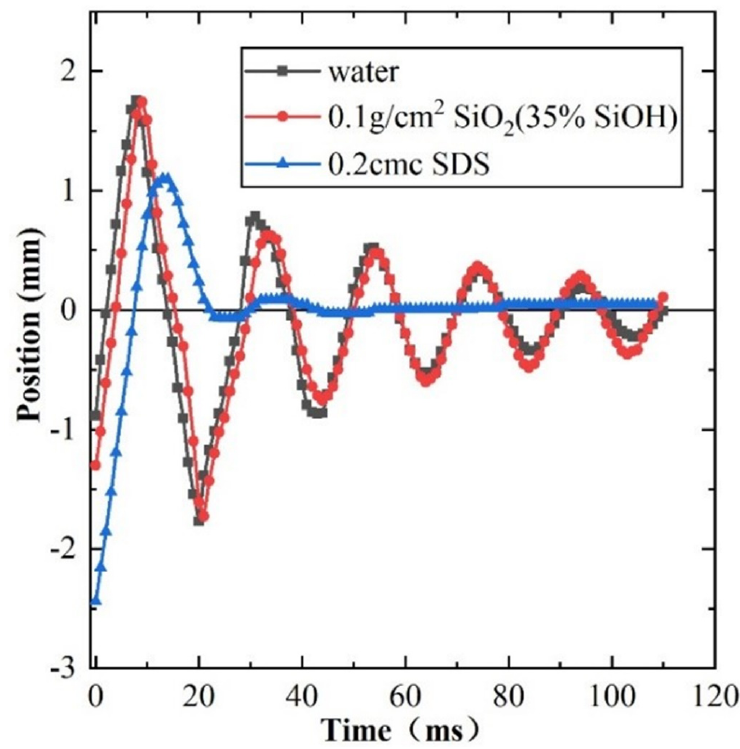
Figure 5. Bubble oscillation at the gas − liquid interface.